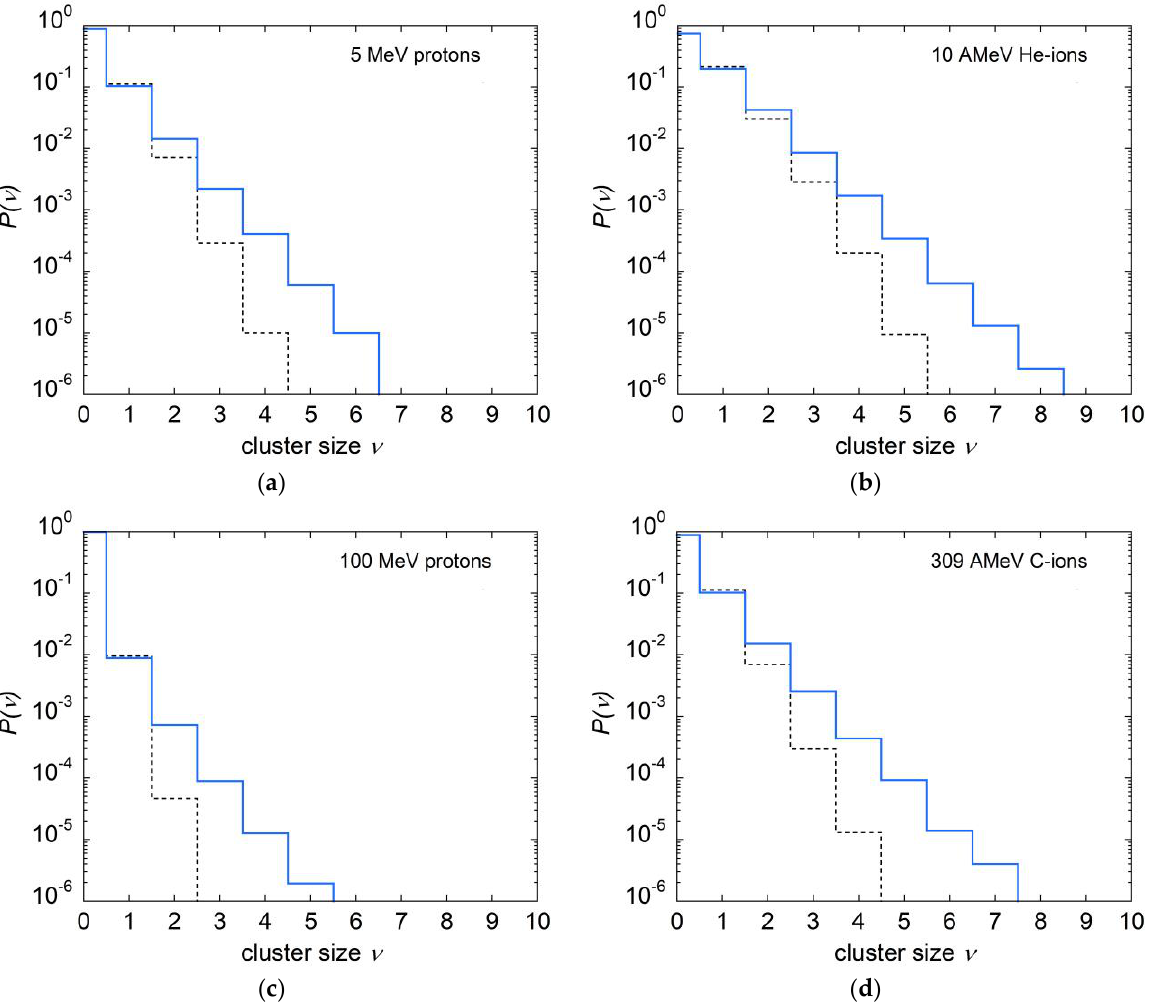
Figure 7. Total ionization cluster size distributions (blue lines) and distributions of the number of ionizations due to direct interaction of the primary particles (dashed lines) for ( a ): 5 MeV protons, ( b ): 10 AMeV He-ions, ( c ): 100 MeV protons and ( d ): 309 AMeV carbon